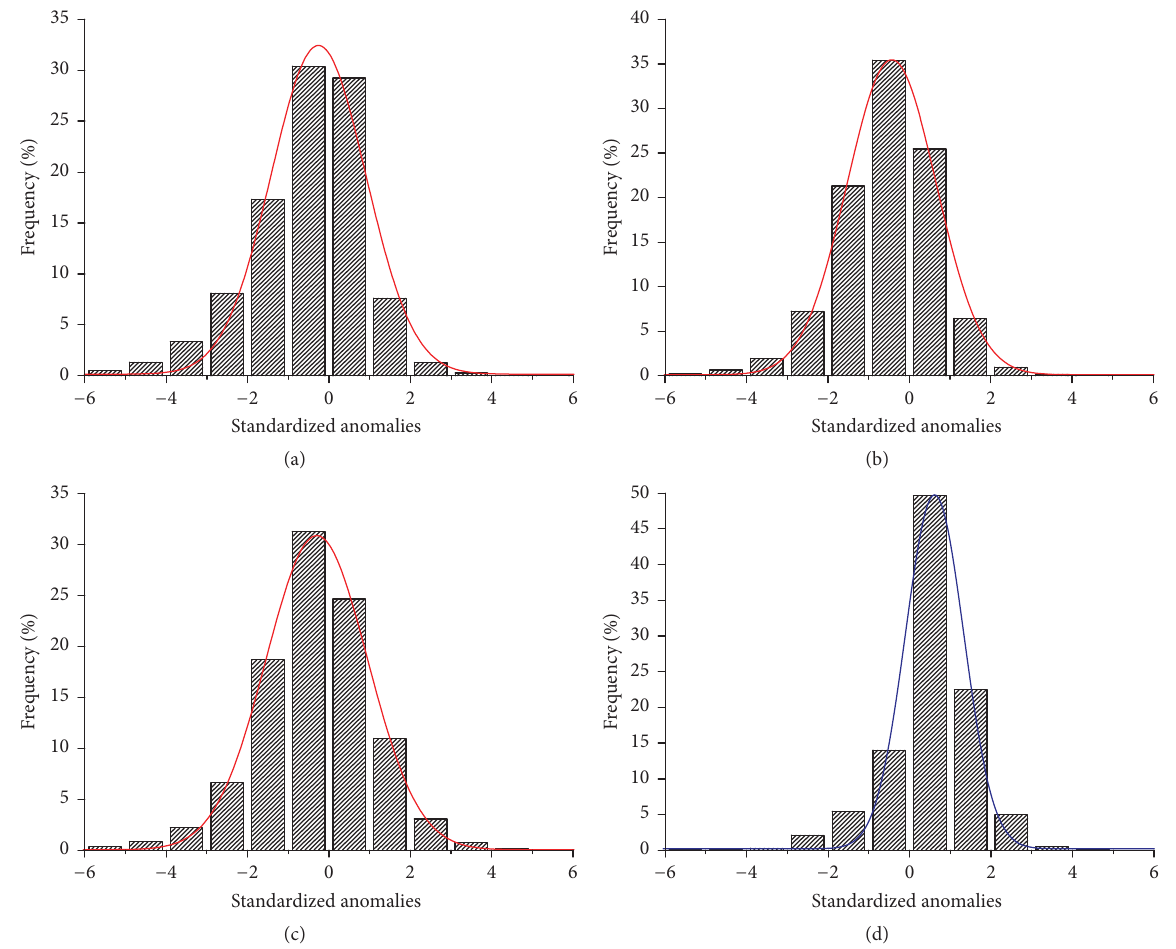
Figure 5: Frequency distributions of standardized anomalies: (a) for NDVI, (b) for EVI, (c) for NDWI, and (d) for LST during the drought period in vegetated areas, which suffered from the 2009/2010 drought over southwestern